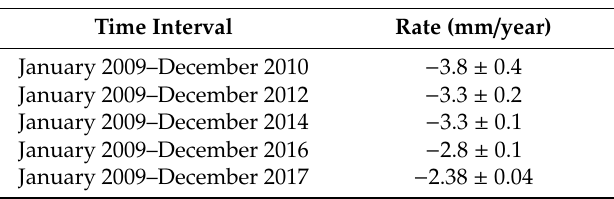
Table 2. Mean subsidence rates estimated by daily time series of Codigoro CGPS station (CODI) over some analyzed time intervals